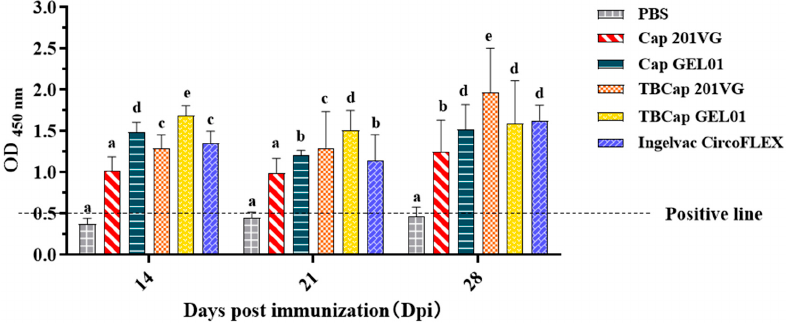
Figure 4. The OD450 of each group at different days post-immunization (dpi) by PCV2 ELISA. Different superscripts (a, b, c, d, e) indicate significant differences among groups ( p < 0.05).